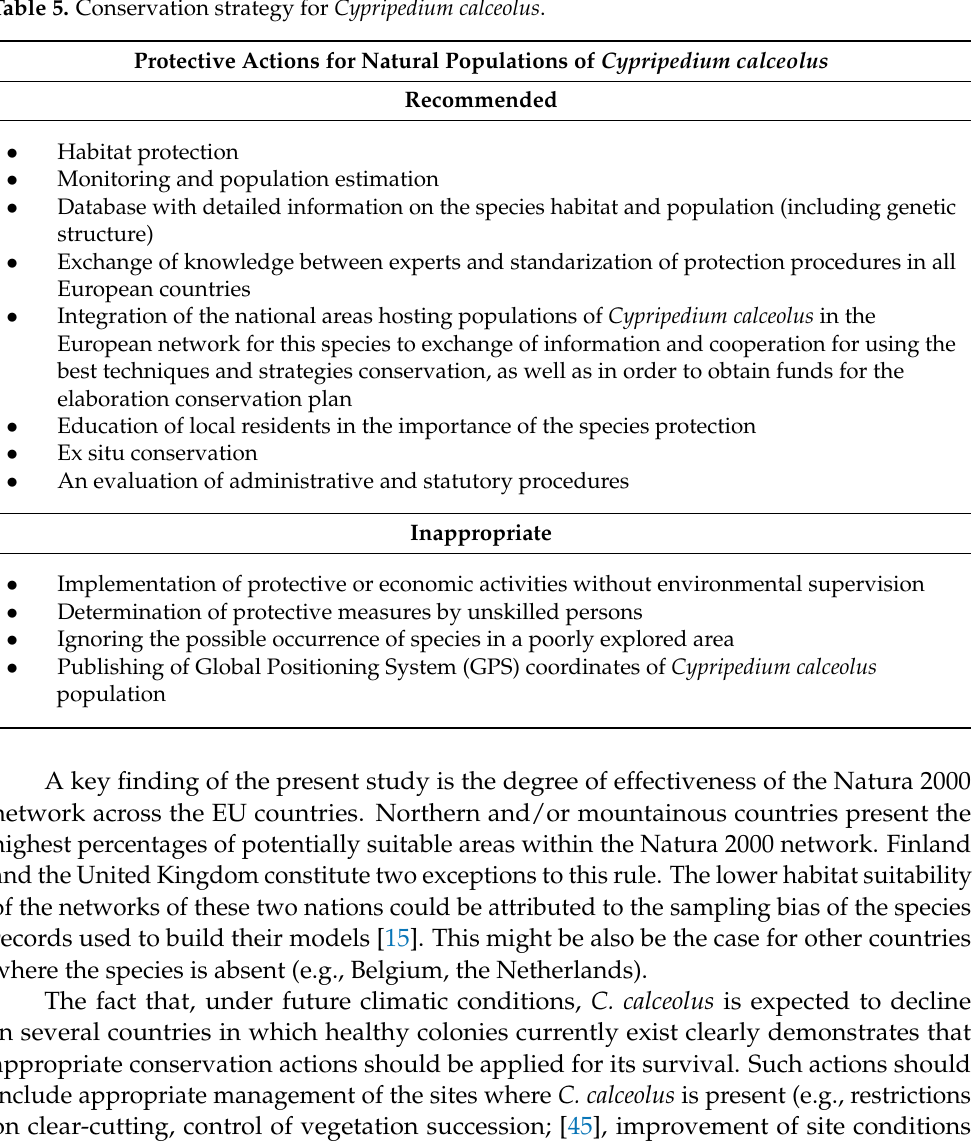
Table 5. Conservation strategy for Cypripedium calceolus